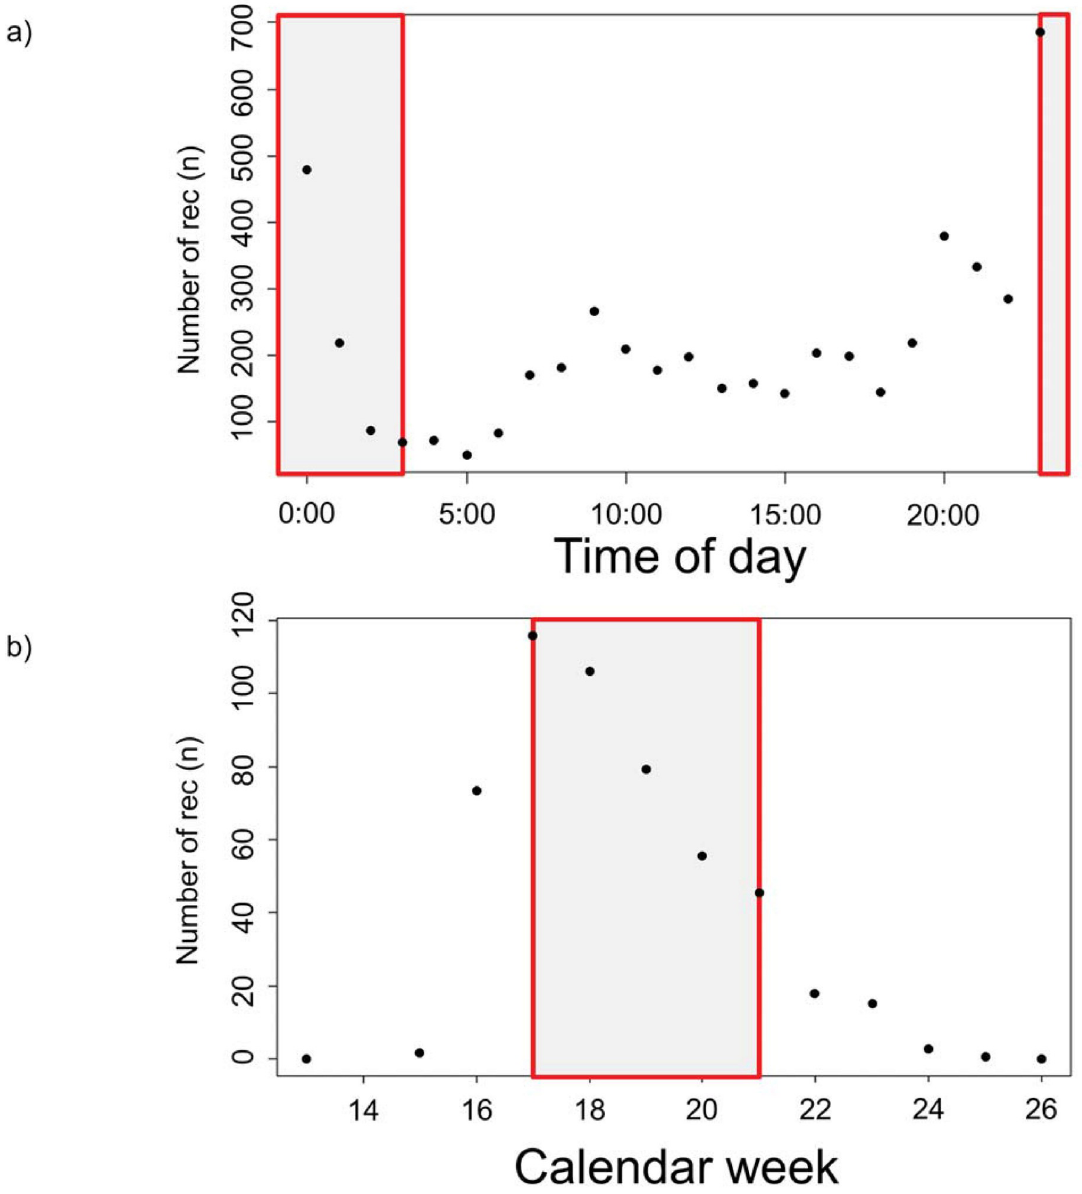
Fig 3. Temporal distributions of 5,679 citizen science recordings (abbreviated as rec) with the ’Naturblick’ app for 2019. In red, the times of previous six nightingale studies are shown (2004–2017; [61–64,79, 80]). a) Representation of the number of recordings in relation to the time of day. b) Presentation of the weekly number of recordings in the course of the breeding season. https://doi.org/10. 5281/zenodo.4817236. The signal-to-noise ratio (SNR) in CS and EX recordings The EX recordings had in all song type categories a mean SNR that was higher than 10 dB. The CS recordings only had a median higher than 10 dB for the song type category whistle and trill. The SNRs of CS data differed significantly among all song type categories (whistle, trill and buzz) from the EX data (whistle: Wilcoxon signed rank test: W = 287, p-value = 0.016, trill: Wilcoxon signed rank test: W = 316, p-value = 0.048, buzz: Welch test: t = -5.5705,